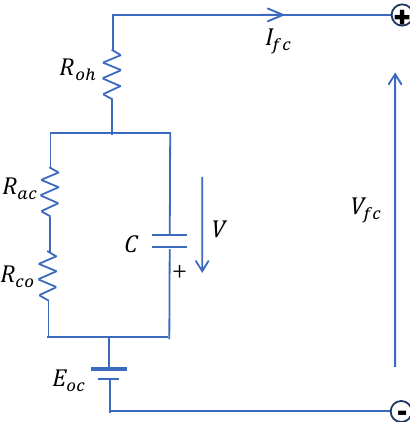
Figure 4. Equivalent electric RC circuit of a fuel cell stack.